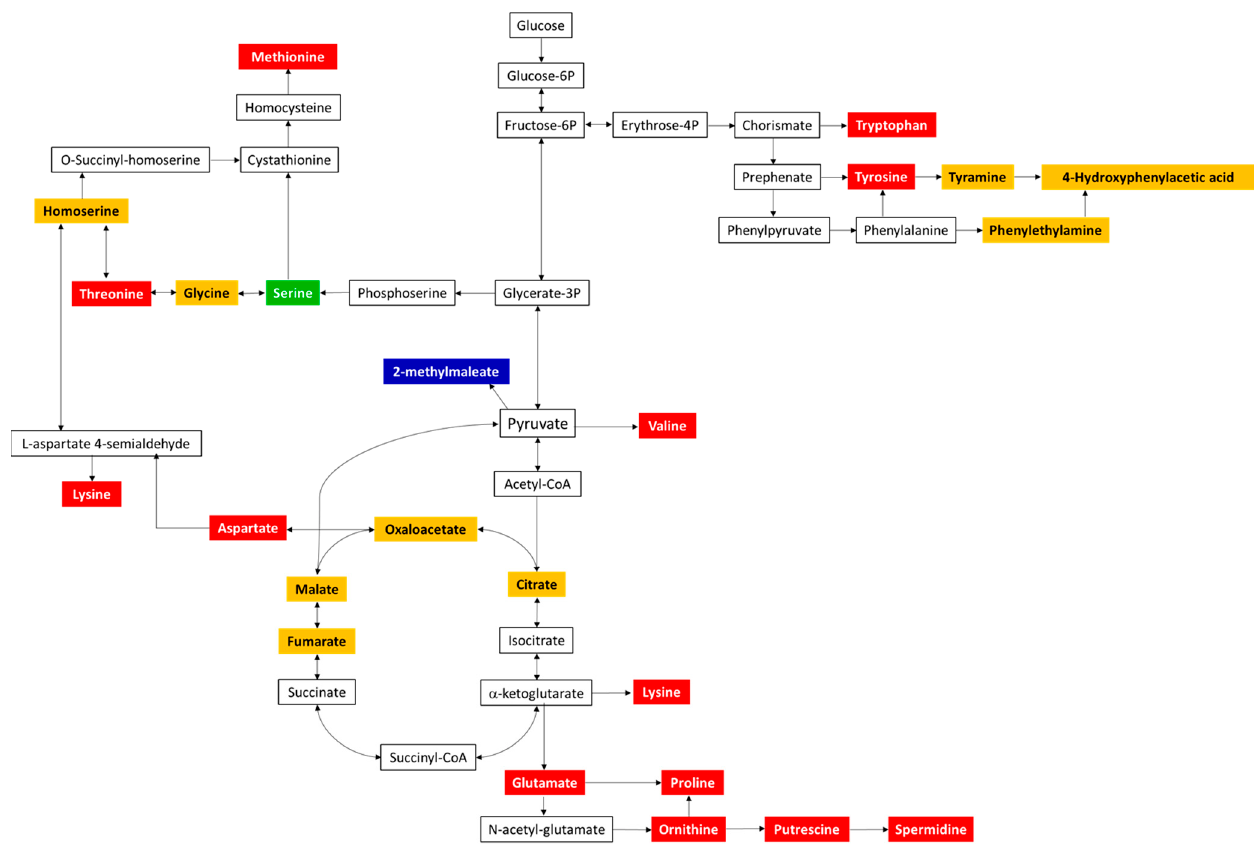
Figure 11. Pathway mapping of statistically significant (( p ≤ 0.05 and FC ≥ 2 or ≤ 0.5) metabolites of RG1 and RG2 identified in the inoculated spinach experiments. Significant metabolites common to both risk groups are highlighted in red, those belonging to RG1 only are highlighted in blue, and those belonging to RG2 only are highlighted in green. All other identified metabolites (but non-significant) are highlighted in orange. Unidentified metabolites are in black. L-methionine is the only amino acid that was upregulated; all other amino acids were downregulated.